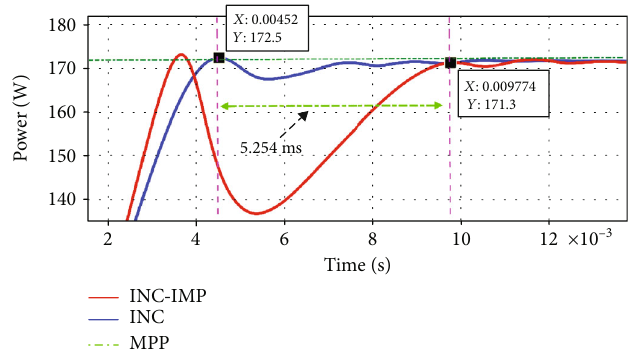
Figure 23: The response speed comparison for Figure 21(b).